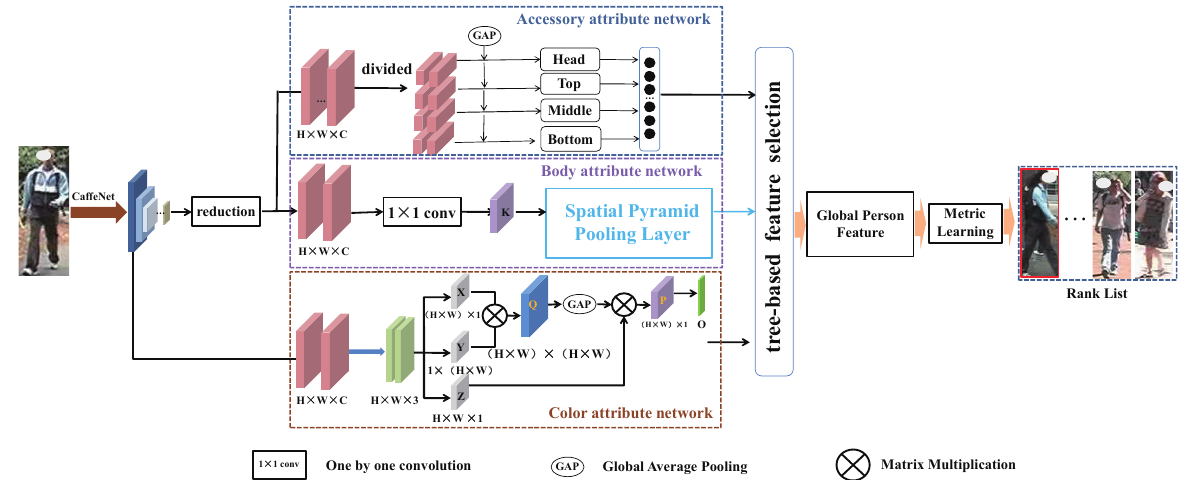
Figure 2. The person multi-attribute feature generation framework for person re-ID. The framework is equipped with three modules, which are denoted as the accessory attribute network, the body attribute network, and the color attribute network to generate the accessory descriptor, the body descriptor, and the color descriptor, respectively. Then, the descriptors are via a tree-based feature selection method for global person feature. The metric learning manner is exploited to obtain person re-ID final